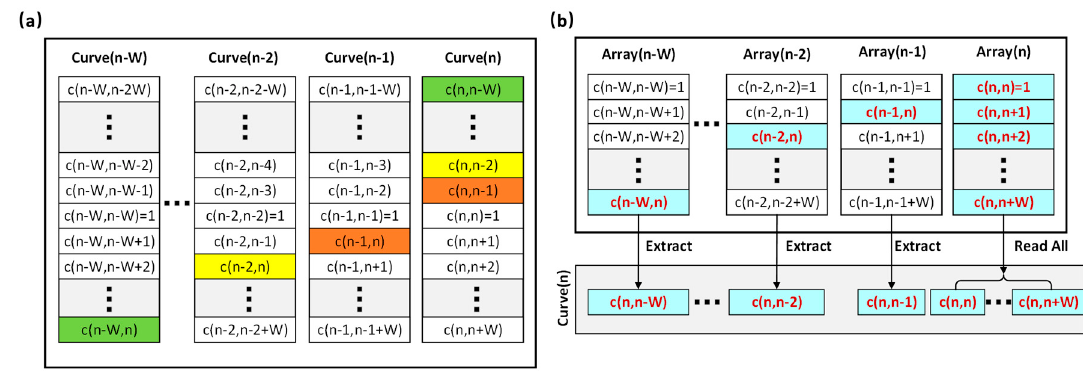
Figure 4. Correlation-computing method in the algorithm. ( a ) Original method. ( b ) Optimized method.